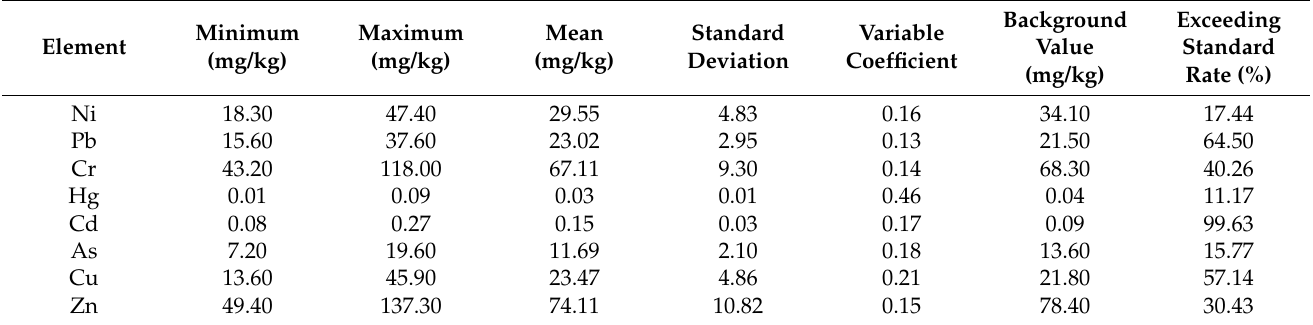
Table 1. Statistical characteristics analysis of sample